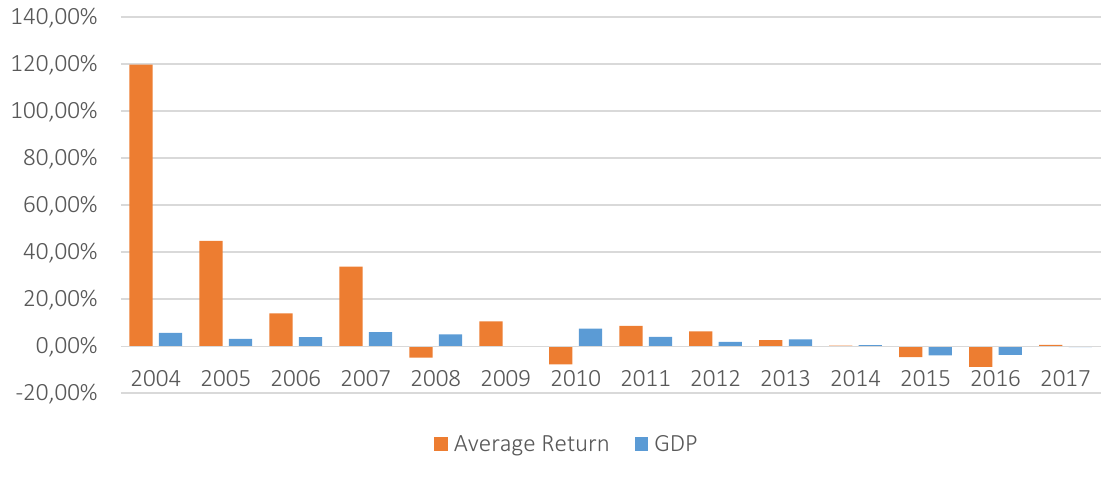
Figure 1. Comparison of the average return of FIPs and Brazilian GDP between 2004 and